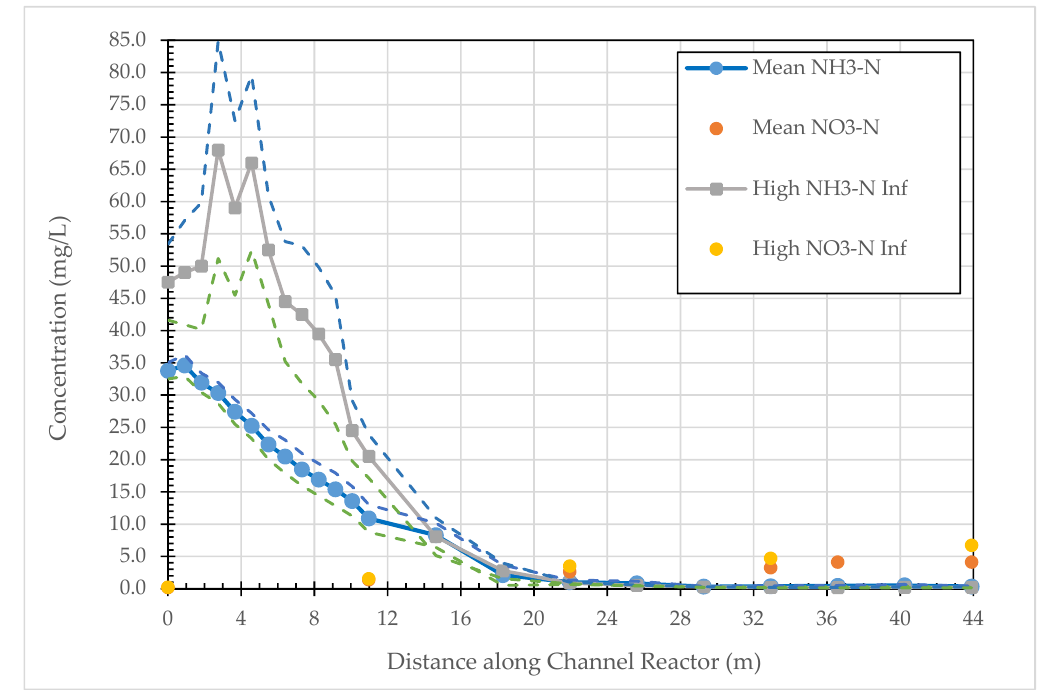
0.05.010.015.020.025.030.035.040.045.050.055.060.065.070.075.080.085.0 Figure 2. Mean ( n = 12) and standard error ammonia and mean nitrate concentrations along the zeolite-anammox linear reactor during the constant flow (September 2012 to August 2013 and November to December 2013) and low-flow ( n = 3), high NH 3 -N influent (August to October 2013) periods at Hayward Marsh reactor.